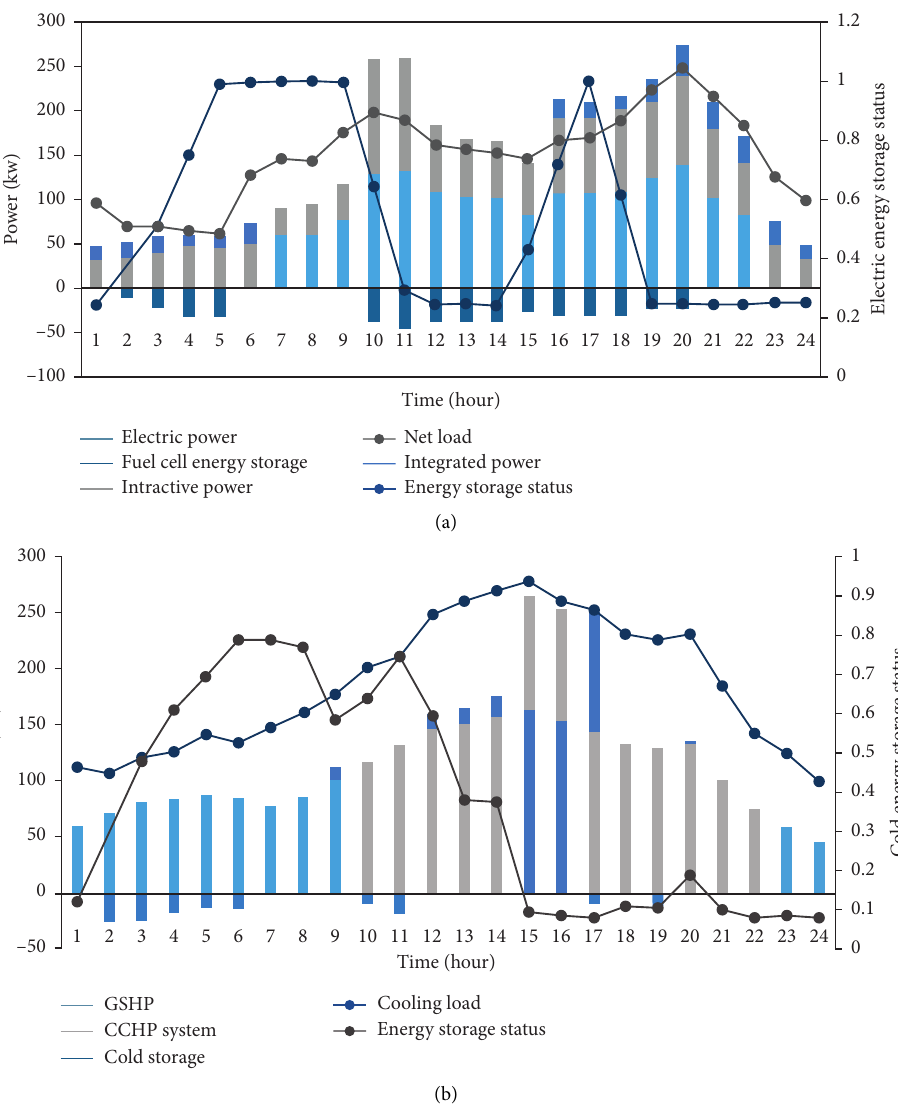
Figure 4: Summer heat pump and cold storage optimization.